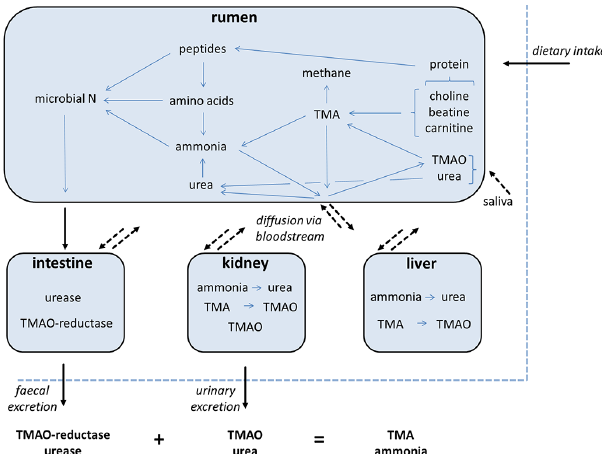
Figure 5. Main pathways of TMA and NH 3 production by the ru- minant system (with the focus on